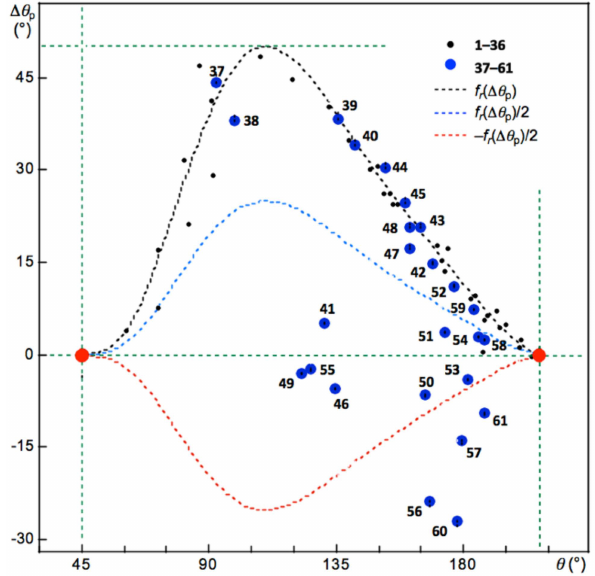
Figure 4. Plots of ∆ θ p versus θ for 37 – 61 , evaluated with MP2/BSS-A’. Numbers are the same as the numbers in Table 1. Red circles correspond to the θ period of 45.0 ◦ ≤ θ ≤ 206.6 ◦ and green horizontal lines are for ∆ θ p = 0 ◦ and 50.0 ◦